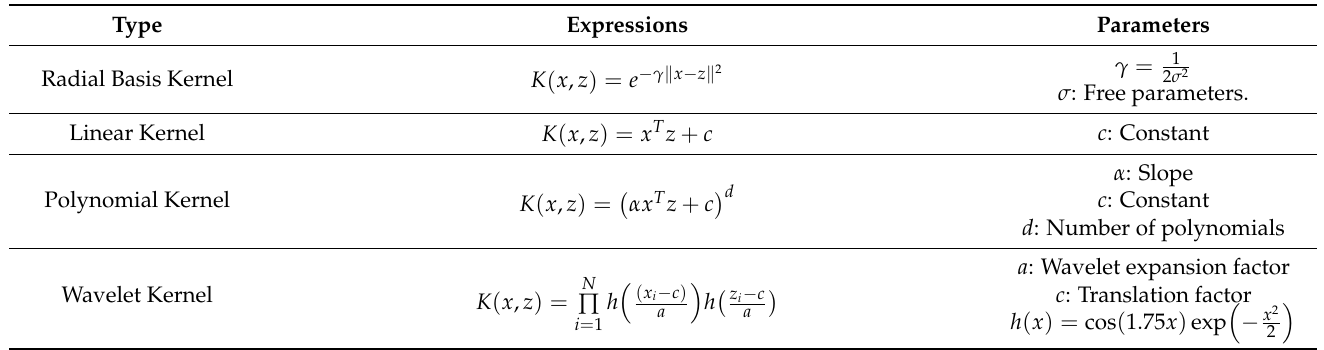
Table 1. The prediction results of different prediction models, x and z are both input